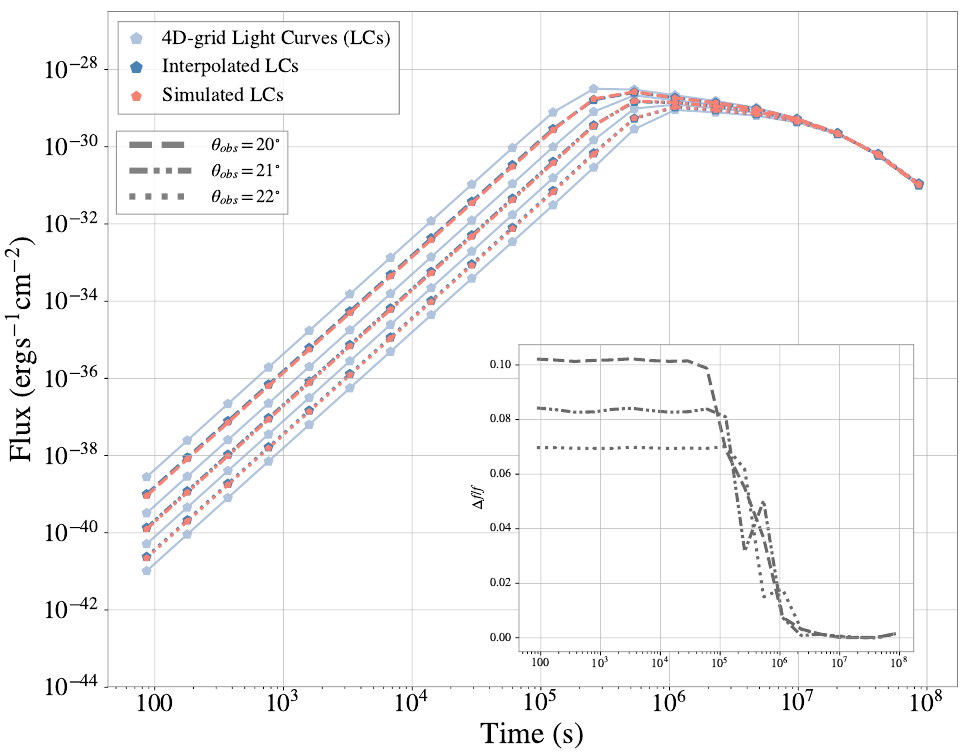
Figure 2. A comparison between the interpolated (dark blue) and simulated light curves (red) at observation angles of θ obs = 20 ◦ ,21 ◦ and 22 ◦ . These observing angles lie in the midpoints of the 4D-grid of simulated light curves (light blue) used to perform the interpolation. The inset shows the fractional difference between the interpolated light curves and the simulated light curves. Note that all parameter values are same as Figure 1 except for a slightly wider jet with θ j = 0.3 rad ( ∼ 17 ◦